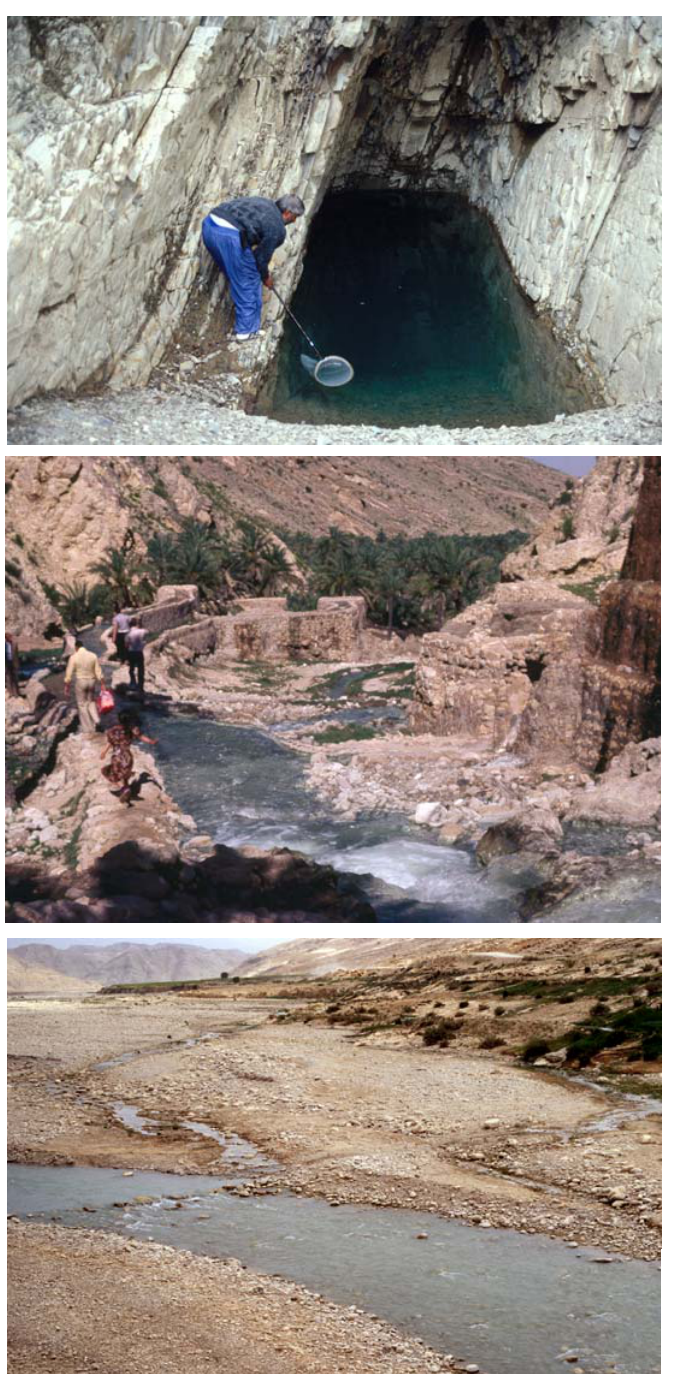
_ F IG . 5. A’la River at Pol-e Tighen, Khuzestan, type locality of Kosswigobarbus